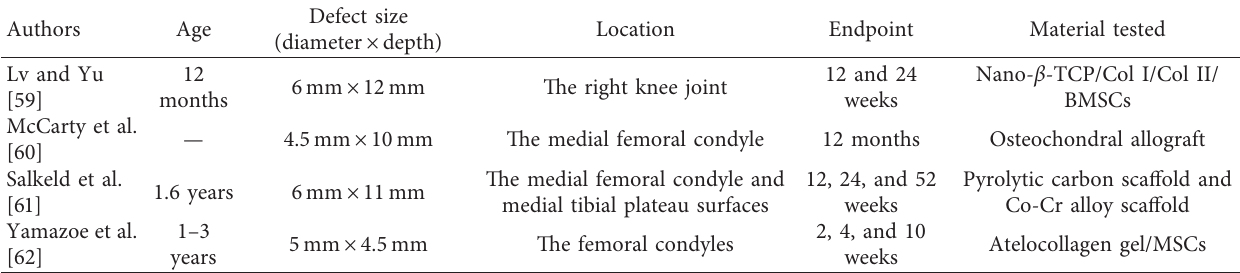
Figure 1: The process of the OCD regeneration in rabbits. A: the OCD were generated by electric drill in the femoral patellar groove; B: a 3.2mm in diameter and 3.0mm deep OCD was obtained; C: the biomaterial was implanted into the Table 4: Examples of studies using dog osteochondral defect models.